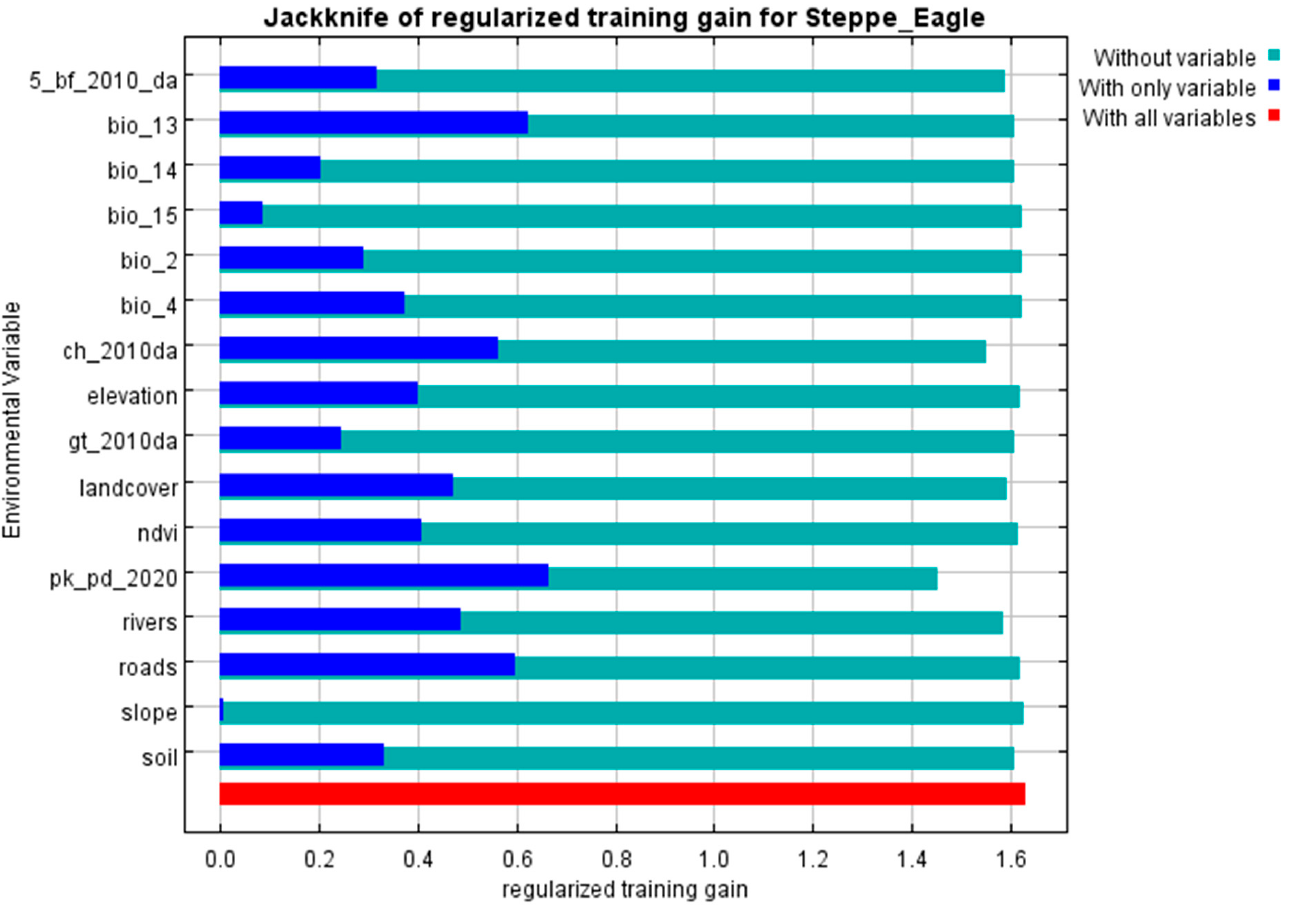
Figure 3. Jackknife test of regularised training gain of variables tested in the steppe eagles habitat suitability model.